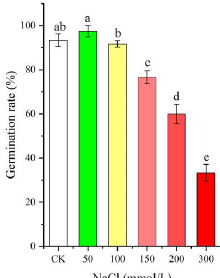
Figure 1. Change in the seed germination rate of Apocynum venetum under different NaCl treatments. Different letters represent a significant difference ( p < 0.05) among different NaCl treatments.